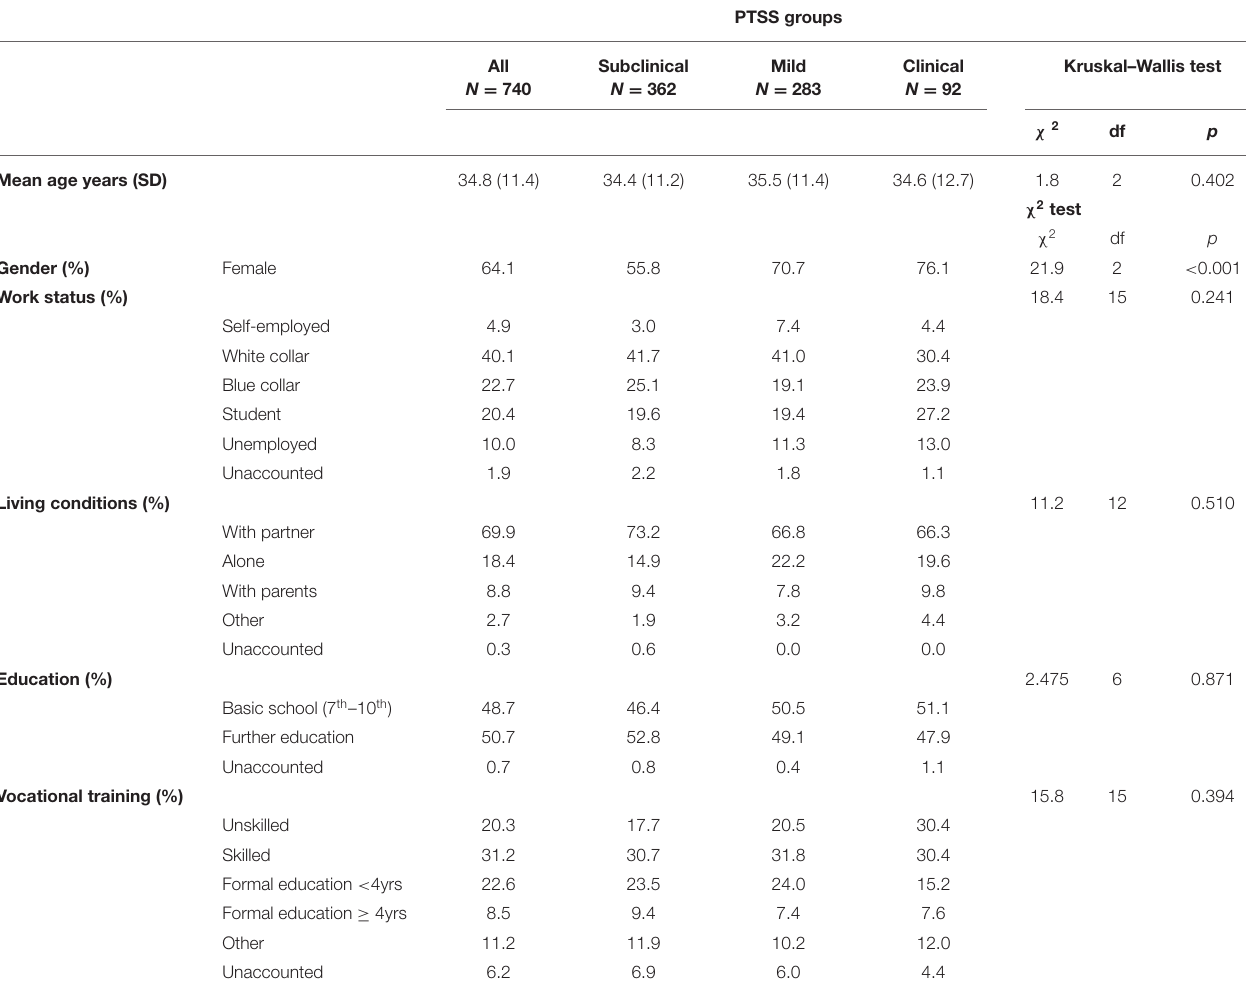
TABLE 1 | Descriptive characteristics at baseline of the overall sample and the three posttraumatic stress symptoms (PTSS)